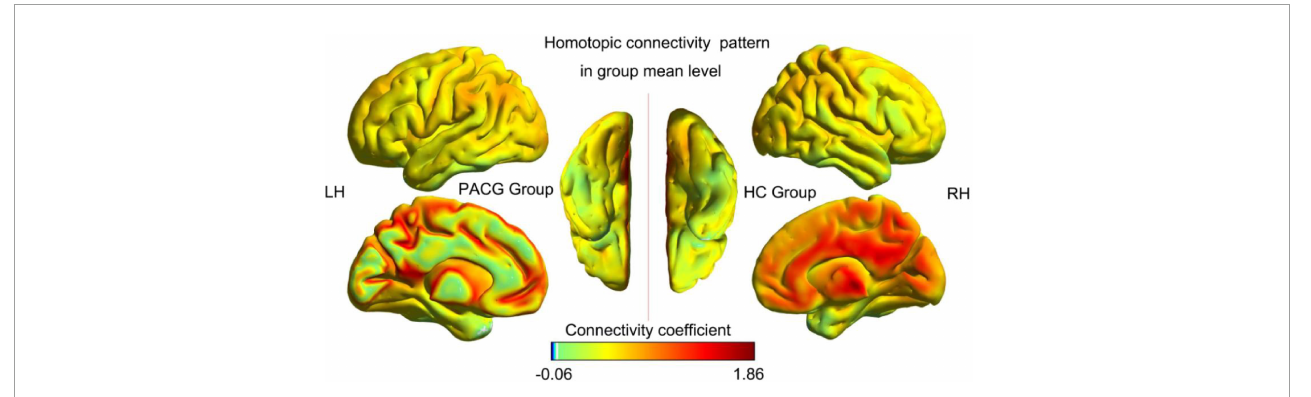
FIGURE1 Voxel-mirrored homotopic connectivity (VMHC) spatial patterns at the group mean level of the primary angle-closure glaucoma (PACG) and healthy controls (HC) groups. LH, left hemisphere; RH, right hemisphere; HC, healthy control; PACG, primary angle-closure glaucoma.